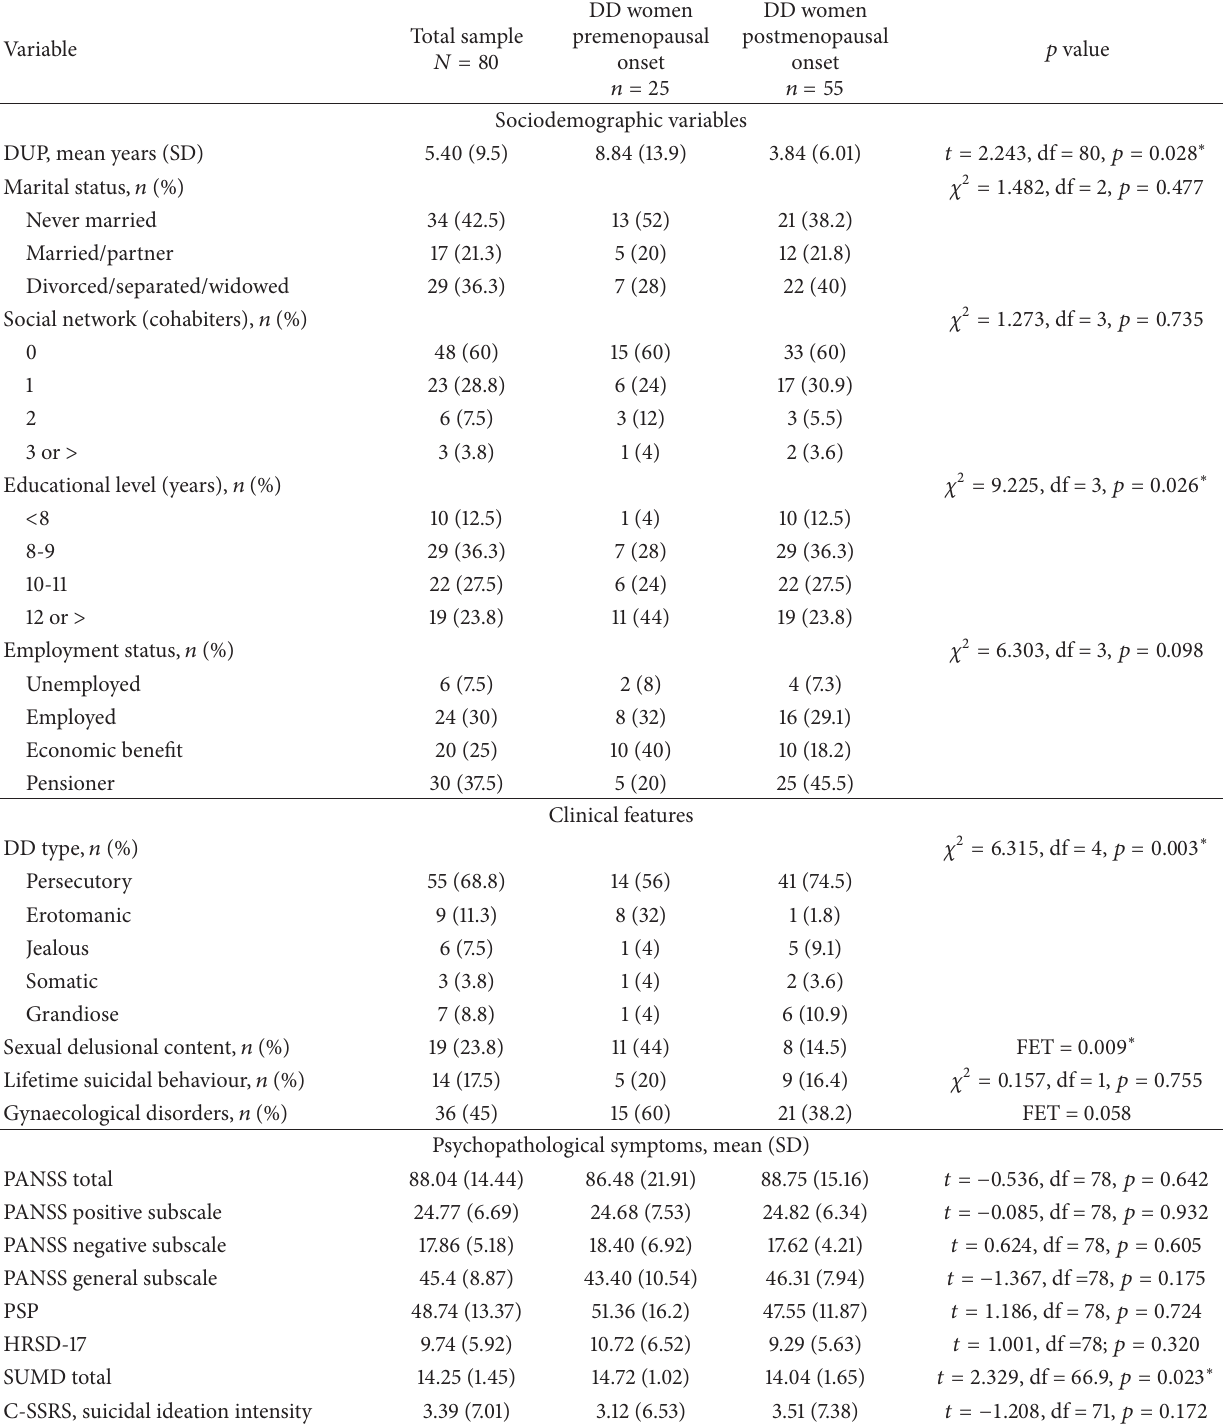
Table 1: Baseline sociodemographic and clinical features and psychopathology symptoms by clinical groups ( 𝑁 = 80